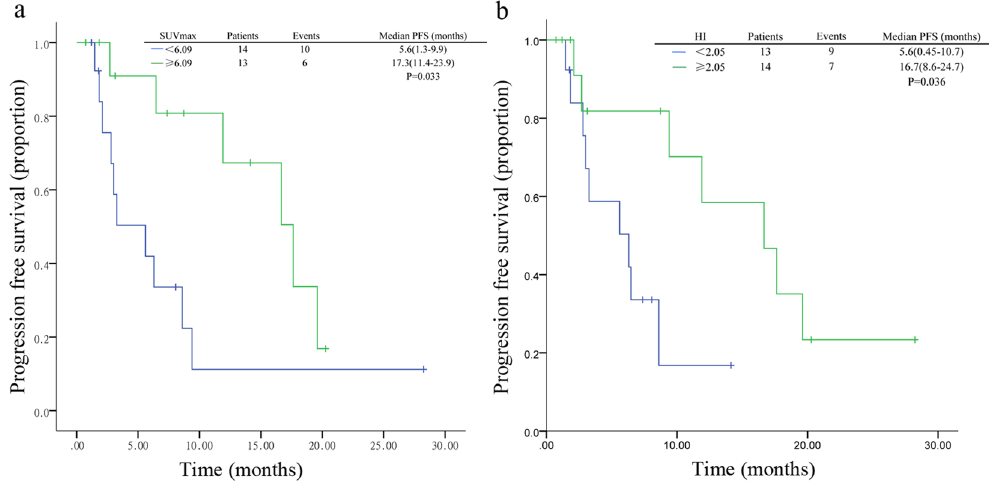
Figure 2. Kaplan–Meier curves for progression-free survival in patients with different imaging parameters. ( a ) For patients stratified by SUVmax. ( b ) For patients stratified by HI. Abbreviations: CI, confidence interval; PFS, progression-free survival. SUVmax, maximum standard uptake value. HI, heterogeneity